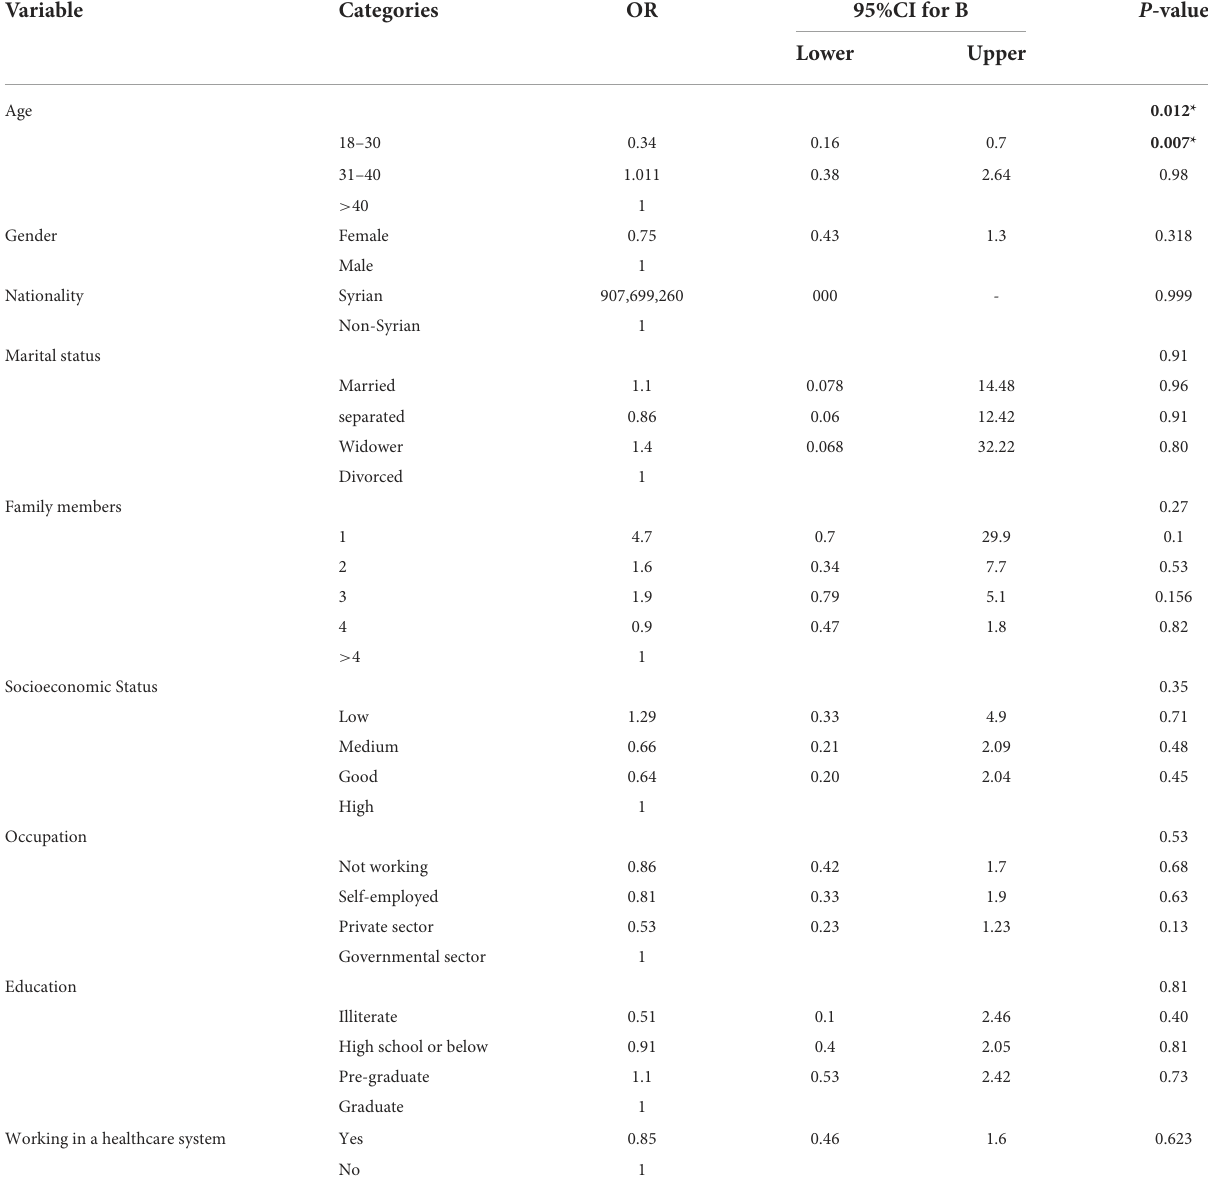
TABLE 4 Predictors related to the parents’ acceptance to vaccinate their children with a COVID-19 vaccine.